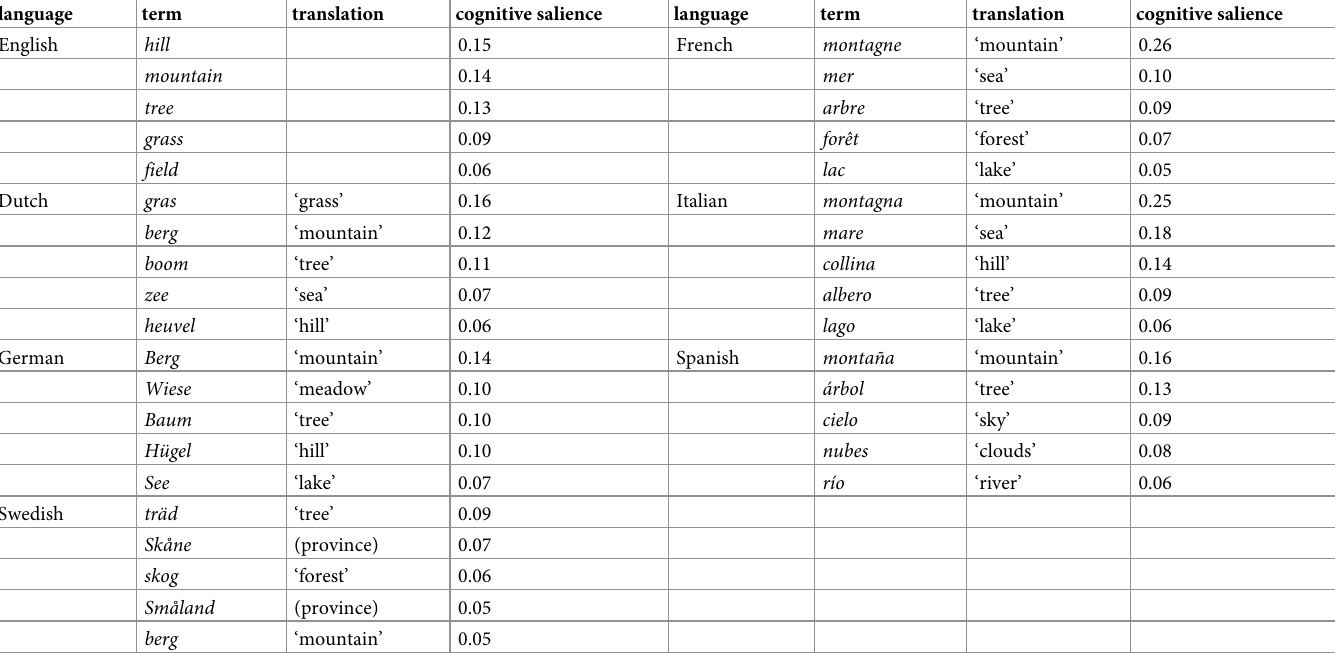
Table 2. The five most cognitively salient landscape exemplars in each language.